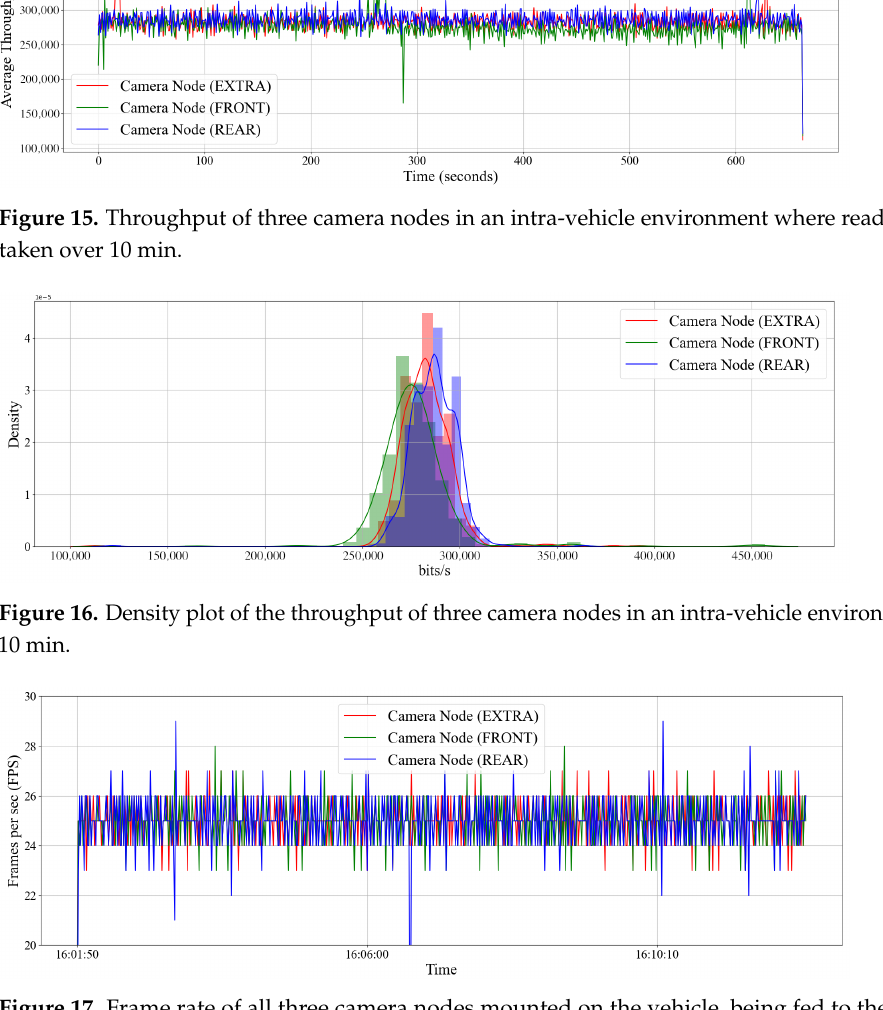
Figure 17. Frame rate of all three camera nodes mounted on the vehicle, being fed to the Android device over a 10-minute